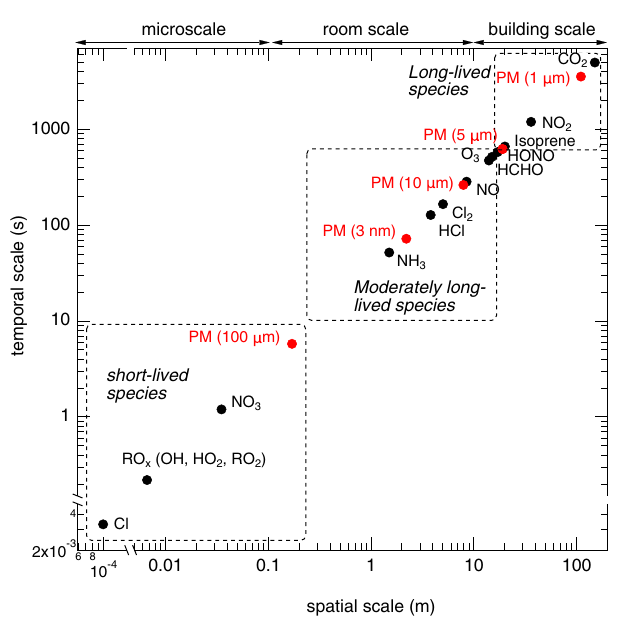
Fig. 3 Spatial and temporal scales of variability for indoor species. Spatial and temporal scales of gas-phase species and particulate matter with different particle diameters indoors with an air exchange rate of 0.5 h − 1